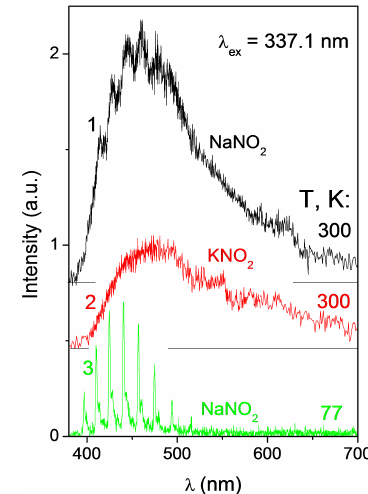
Figure 4. The PL spectra of the NaNO 2 (1 and 3) and KNO 2 (2) samples; T = 300 (1, 2) and 77K (3); λ ex = 337 . 1nm.